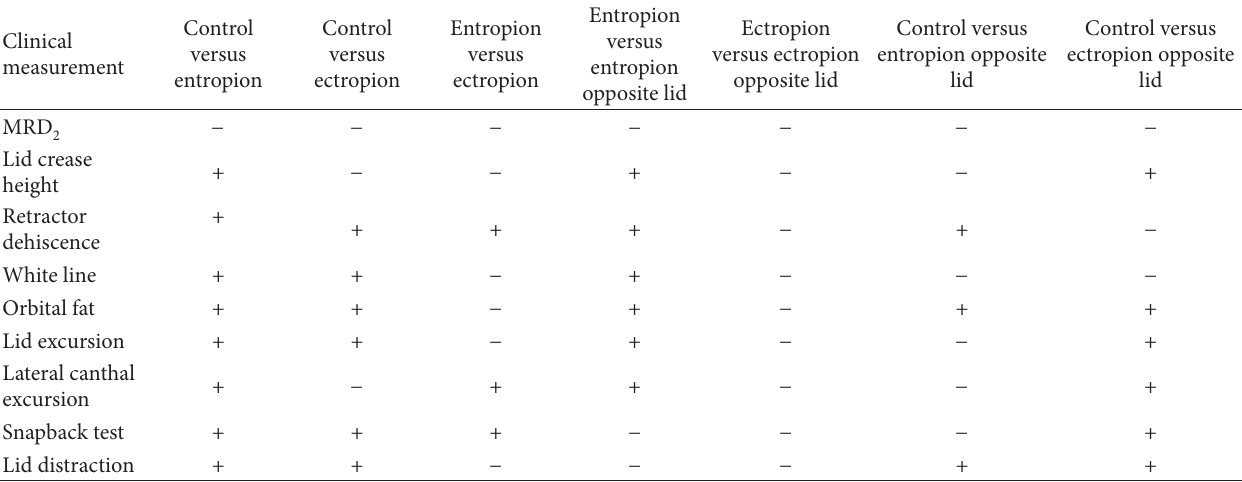
Table 4: Summary of statistically significant